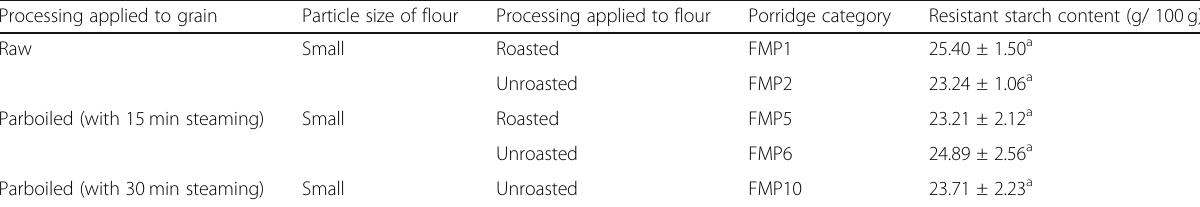
Table 3 Resistant starch content of representative finger millet porridges Processing applied to grain Particle size of flour Processing applied to flour